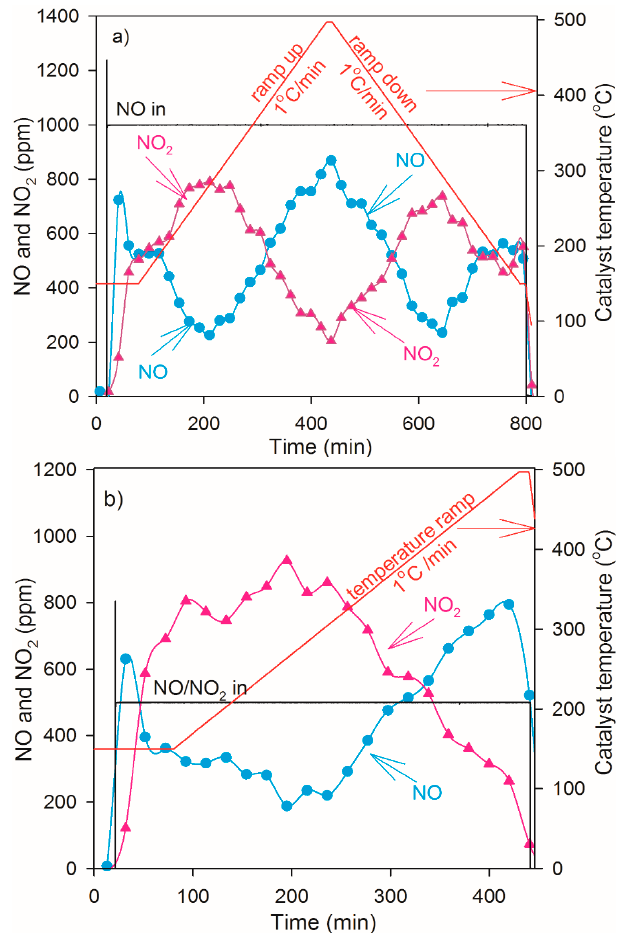
Figure 8. Evolution of NO and NO 2 concentrations as function of the time during ( a ) NO oxidation and ( b ) (NO + NO 2 ) oxidation over 2 wt. % Pt/Al 2 O 3 . Experimental procedures are described in Section 3.